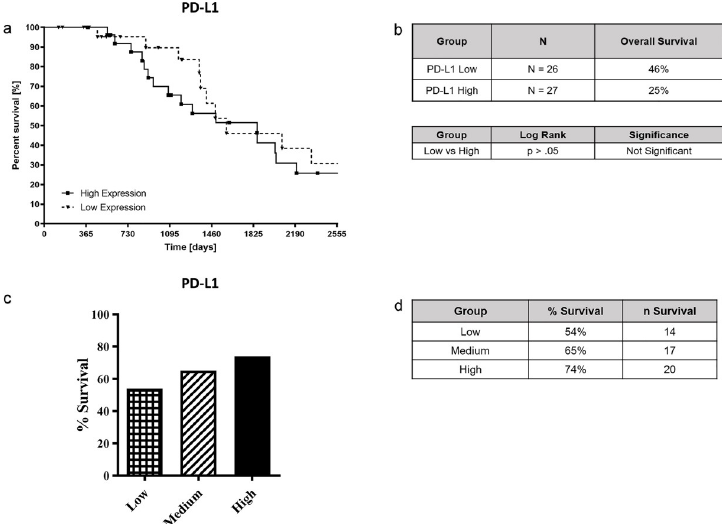
Fig 7. PD-L1 expression and survival analysis of patients with ACC. 79 ACC patients were divided between high (n = 27), medium (n = 26), and low (n = 26) PD-L1 expression and Kaplan-Meier survival analysis was performed to determine survival time over 7-year period (Fig 7A and 7B). In addition, PD-L1 expression and its relationship with ACC survival was assessed (Fig 7C and 7D). Data was analyzed for different PD-L1 expression levels and ACC survival using the Graph Pad Prism software. P values are shown comparing high vs. low